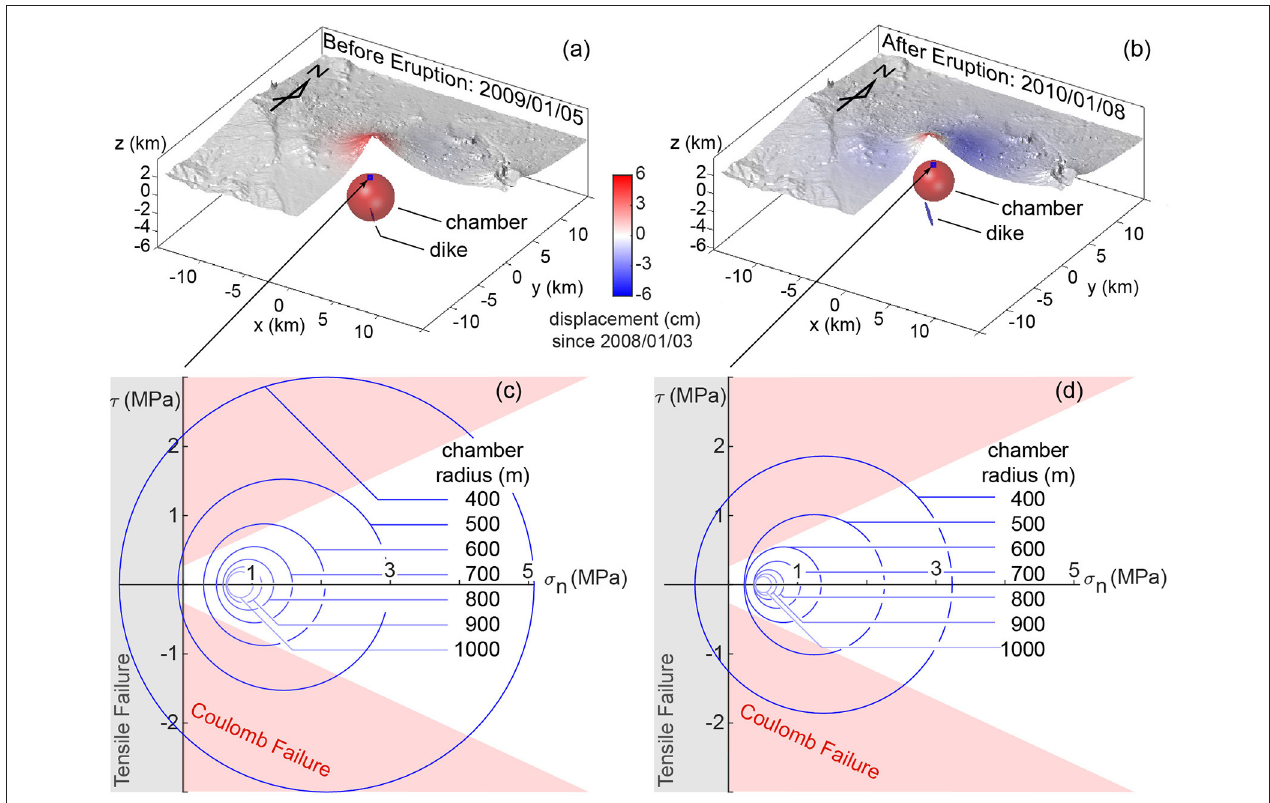
FIGURE 8 | 3D illustrations of the best fit models estimated by EnKF before (a) and after (b) the 2009 eruption. (c,d) Show the estimated Mohr’s circle for the country rock ( Grosfils, 2007; Gregg et al., 2012) directly above the top of the spherical chamber. The predicted stress is sensitive to the radius size, which tradeoffs with the depth of the top of the chamber. Red shaded regions in (c,d) shows the Coulomb-failure envelop (C = 25 MPa, φ = 25 ◦ after Grosfils, 2007). The gray shaded region ( σ n < 0) indicates when the system is in tension. Tensile failure may indicate dike initiation away from the magma chamber and immanent